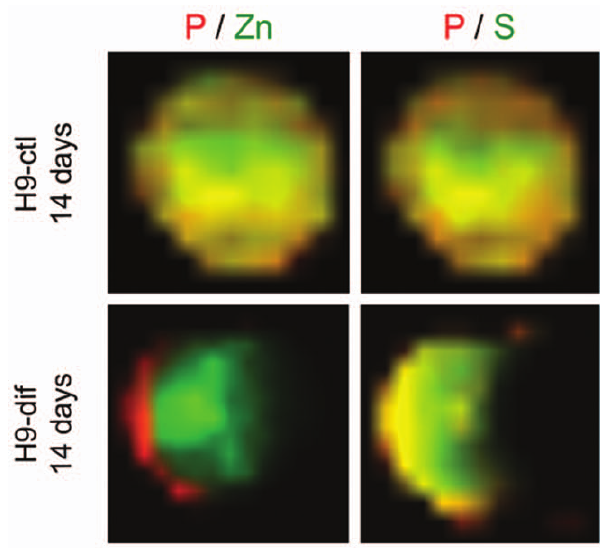
Figure 13. Phosphorus co-localizes with sulfur, but does not overlap with zinc in neural induced EBs.